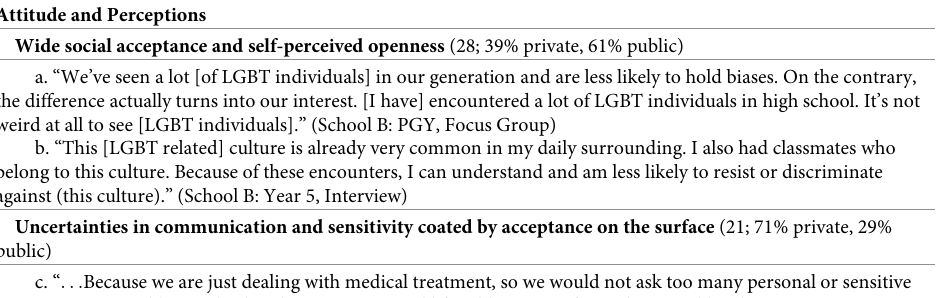
Table 3. Themes, categories, and student quote